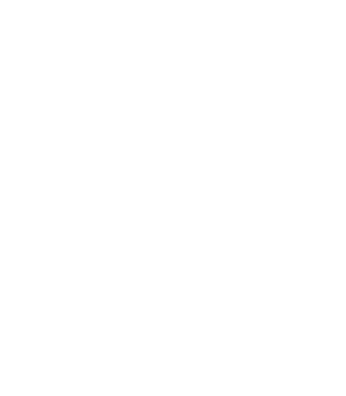
Figure 6: Time dependence of the energy J-integral under cycling loading.